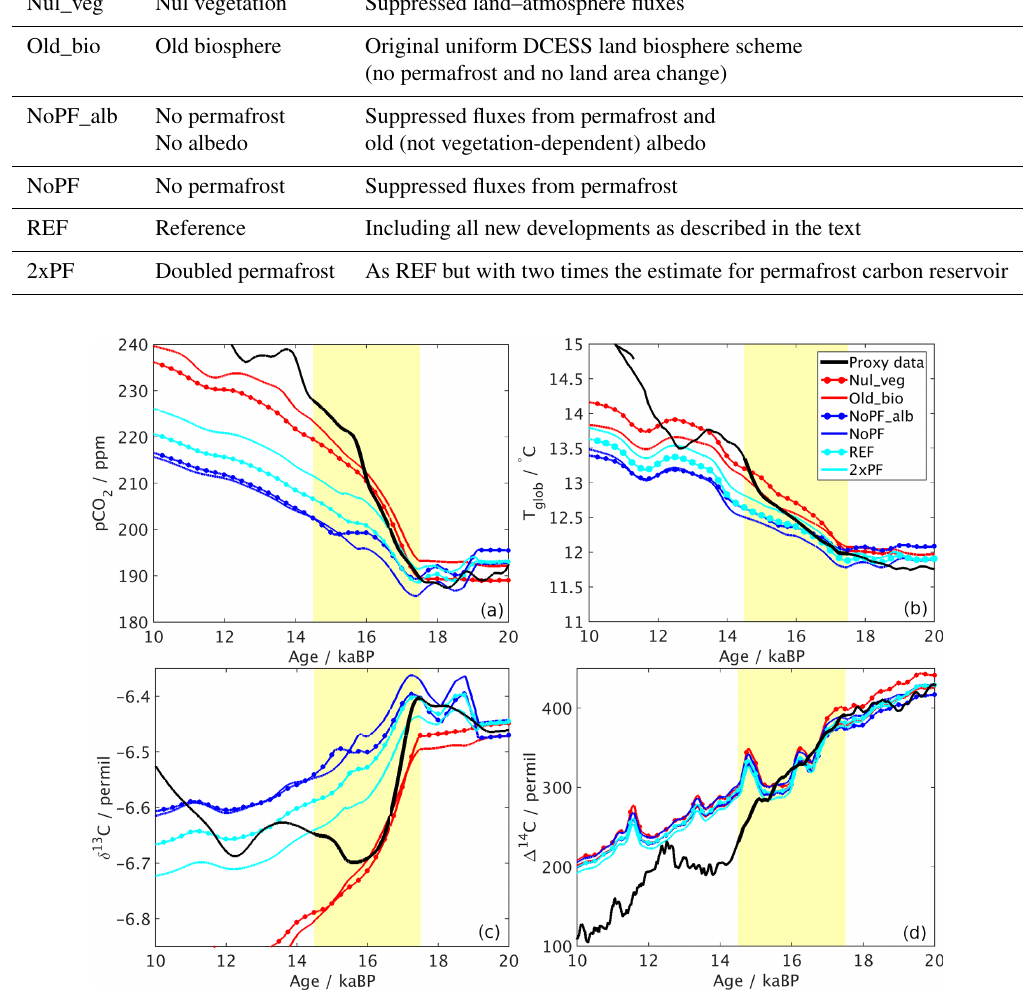
Figure 5. Atmospheric values for the DCESS simulations with null vegetation model (Nul_veg, red line with dots), old biosphere scheme (Old_bio, red line), deactivated permafrost component and old albedo scheme (NoPF_alb, blue line with dots), deactivated permafrost component and new albedo scheme (NoPF, blue line), reference simulation with all new components (REF, light blue line with dots) and sensitivity experiment with doubled permafrost carbon reservoir (2xPF, light blue line) and data-based reconstructions (black). p CO 2 by Lüthi et al. (2008), temperatures by Shakun et al. (2012), δ 13 C by Schmitt et al. (2012) and (cid:49) 14 C by Reimer et al.